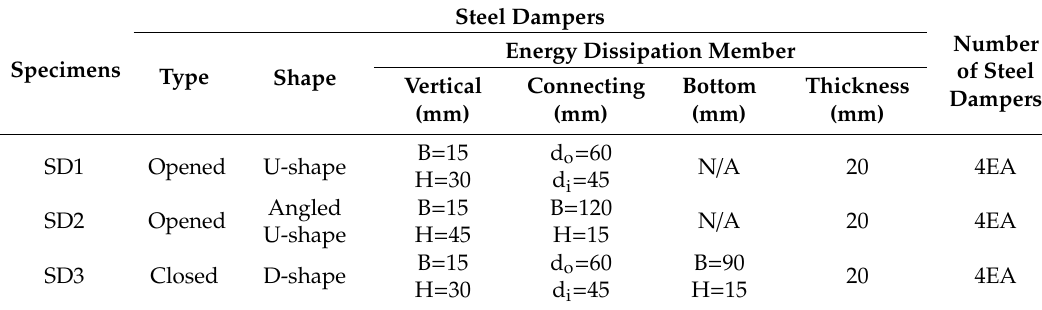
Table 1. Details of